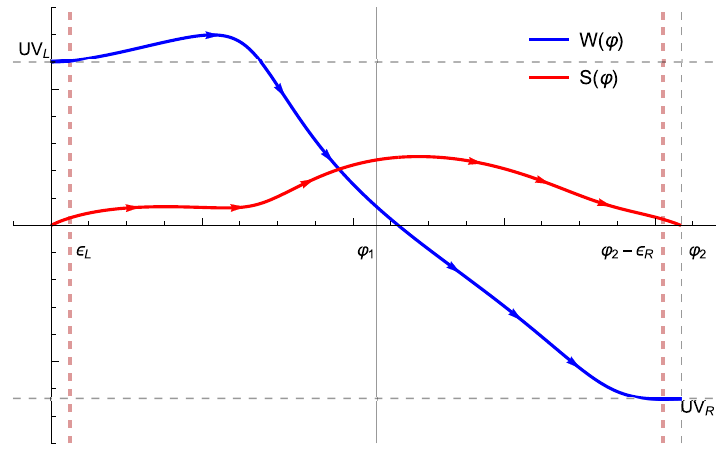
Figure 9 . An example of the W LR